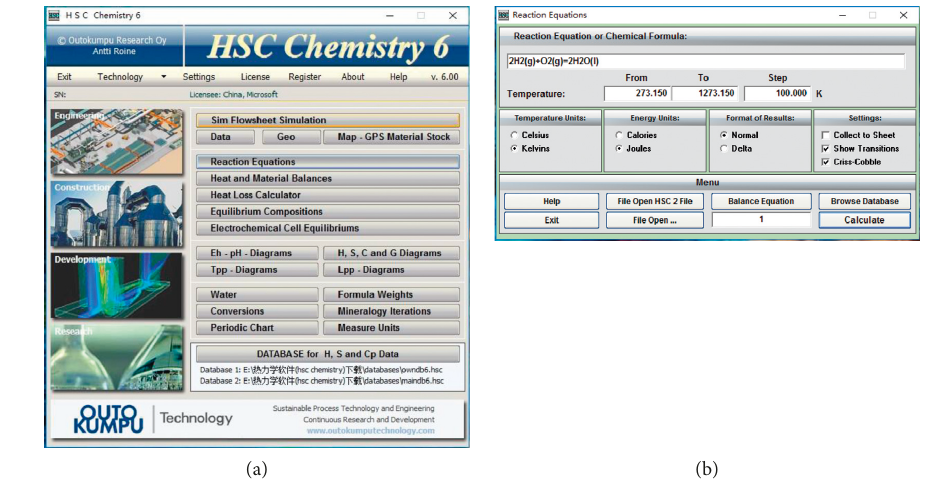
Figure 4: The software interface of HSC Chemistry. Table 2: Gibbs free energy of five samples.